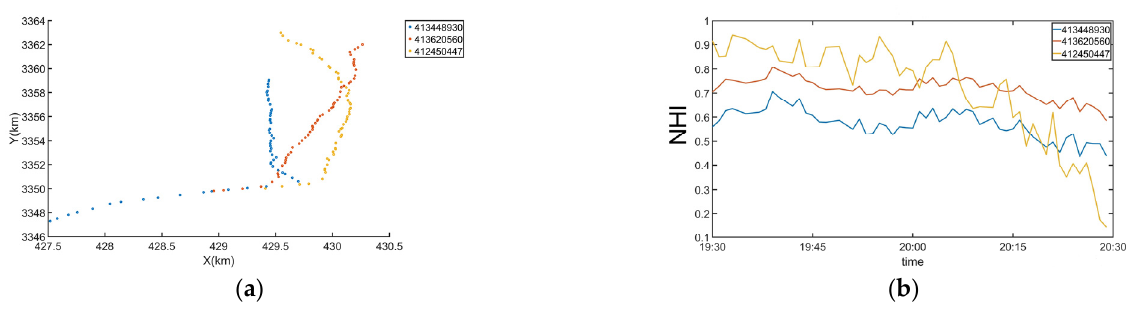
Figure 10. The multi-ship encounter situation: ( a ) the trajectory of the multi-ship encounter situation; ( b ) the NHI curve of the multi-ship encounter situation.